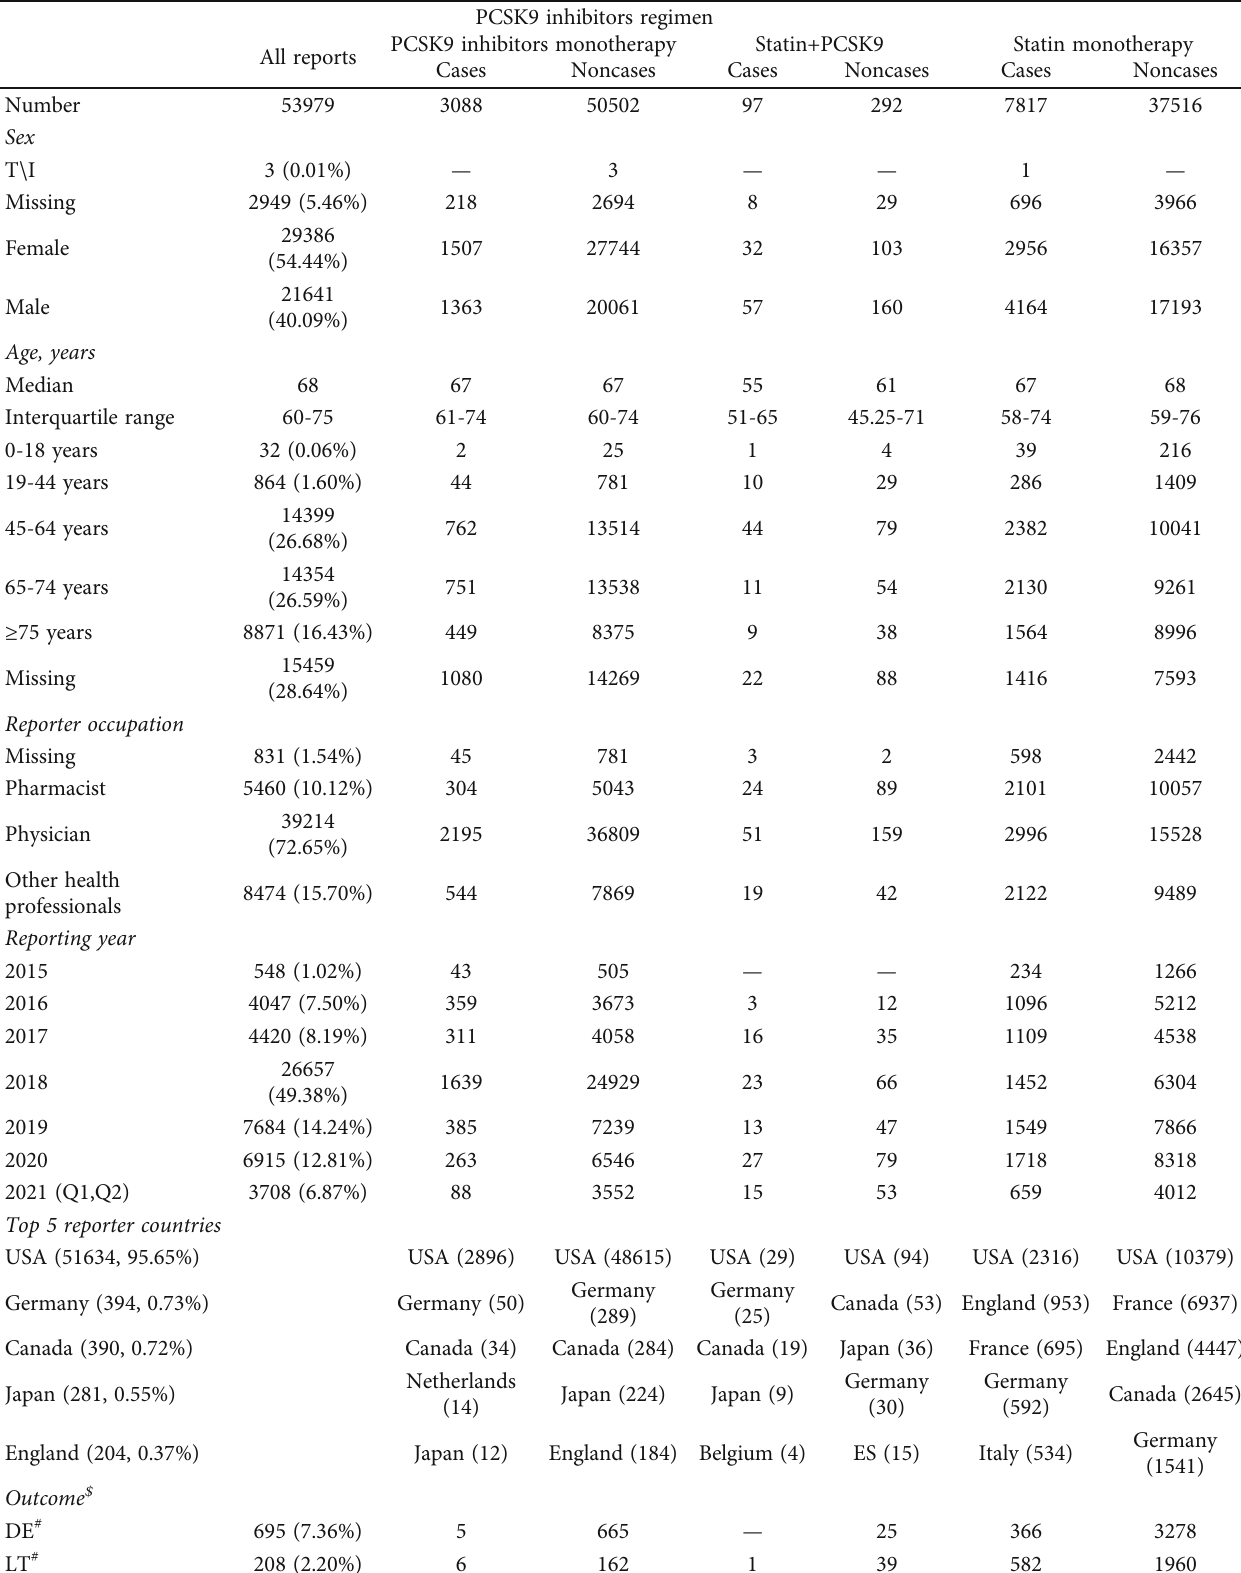
Table 1: Characteristics of reports of interest reported by health professionals in FAERS from 2015 quarter 4 to 2021 quarter 2 of PCSK9